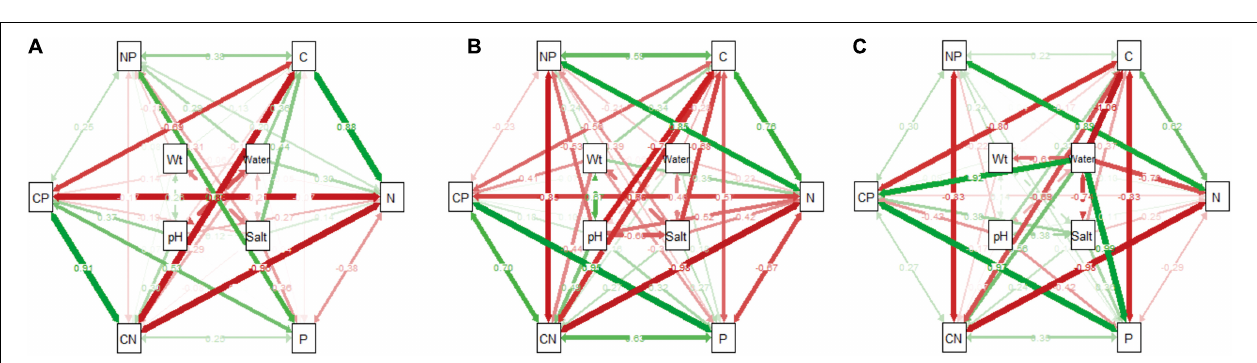
FIGURE 6 | The influence pathways and flux of different habitats on the stoichiometry of P. australis by structural equation model analysis (SEM) (A) wetland, (B) salt marsh and (C) desert; CN represents the C:N ratio; CP represents the C:P ratio; and NP represents the N:P ratio.